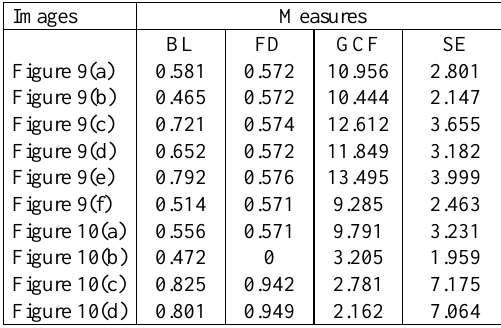
Table 1. Aesthetic evaluation of various result